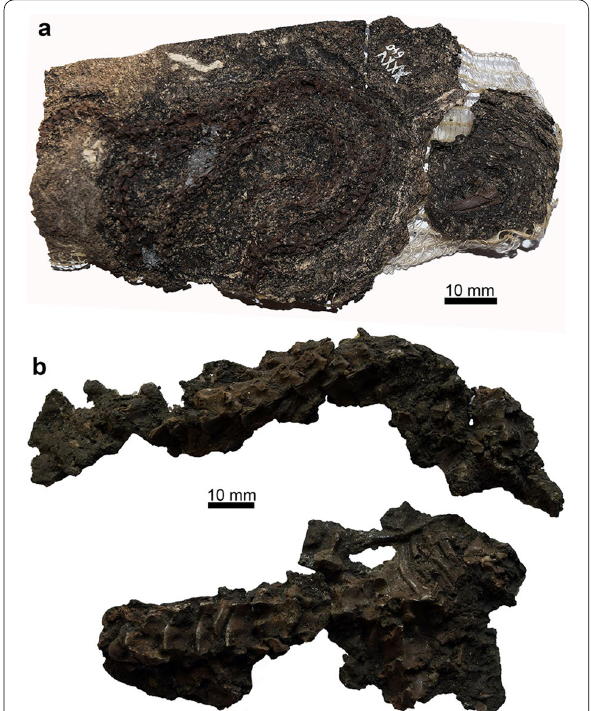
Fig. 109 Constrictores indet. from Geiseltal: a partial skeleton with several trunk vertebrae and ribs, and a dentary (GMH XXXV-640-1970) from quarry XXXV; b two strings of articulated trunk vertebrae and fragments of ribs (GMH Leo I-5866-1932) from quarry Leonhardt I